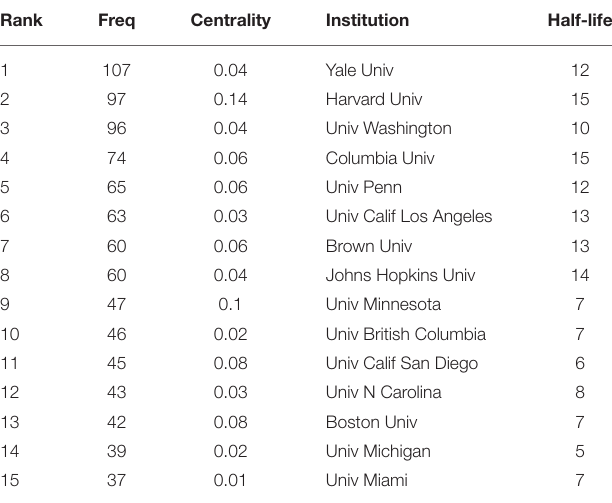
TABLE 2 | Top 15 institutions related to complementary and alternative medicine for substance use disorders. Rank Freq Centrality Institution